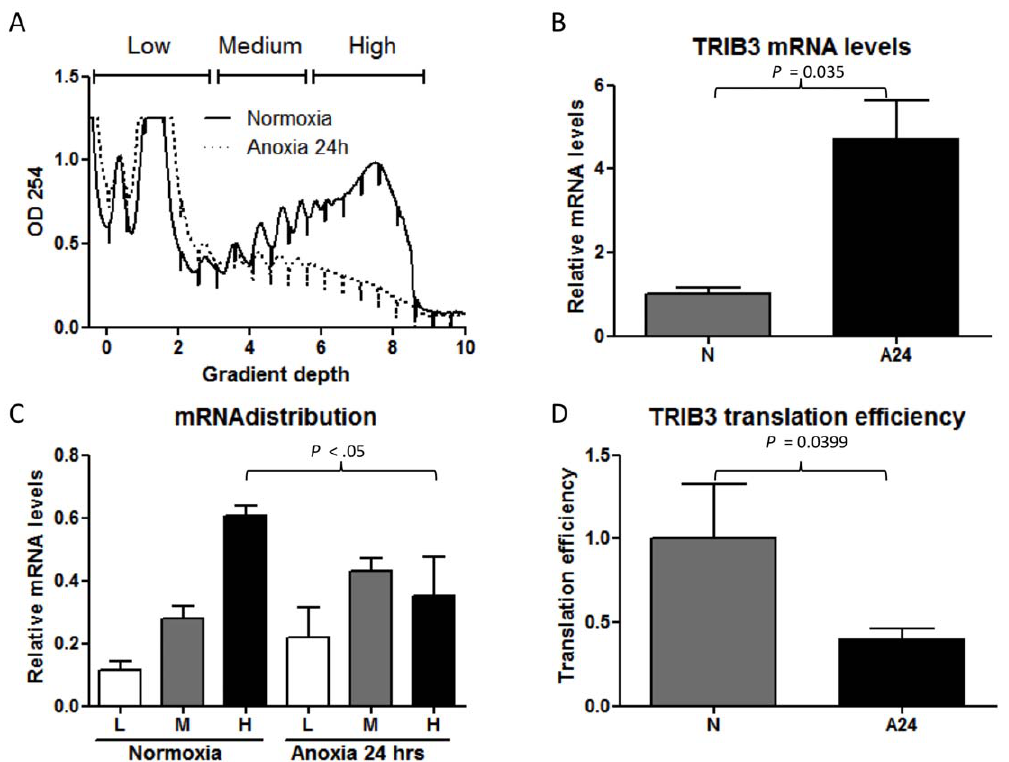
Figure 3. TRIB3 mRNA translation during anoxia. A. Polysome profiles of MCF7 cells grown under aerobic of anoxic conditions during 24 hours. B. TRIB3 mRNA levels determined by Q-PCR in the total RNA fraction. C. TRIB3 mRNA distribution within the polysome. D. Change in translation efficiency of the TRIB3 mRNA after exposure to anoxia for 24 hrs. Experiments were performed in triplicates.